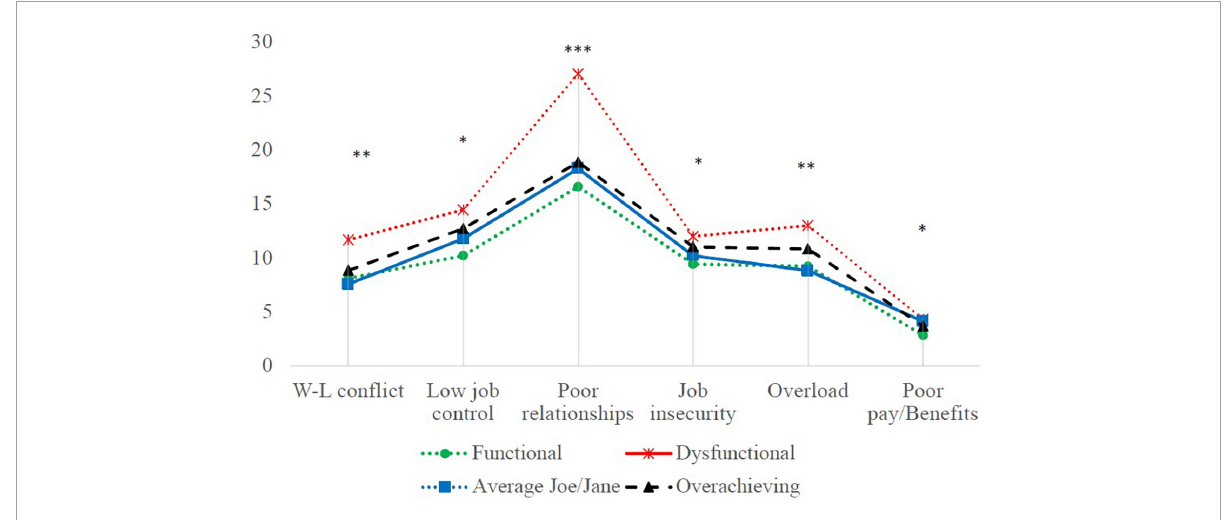
FIGURE3 Differences in exposure to job stressors according to four latent profiles of presenteeism. ∗ p < 0.05, ∗∗ p < 0.01, ∗∗∗ p <